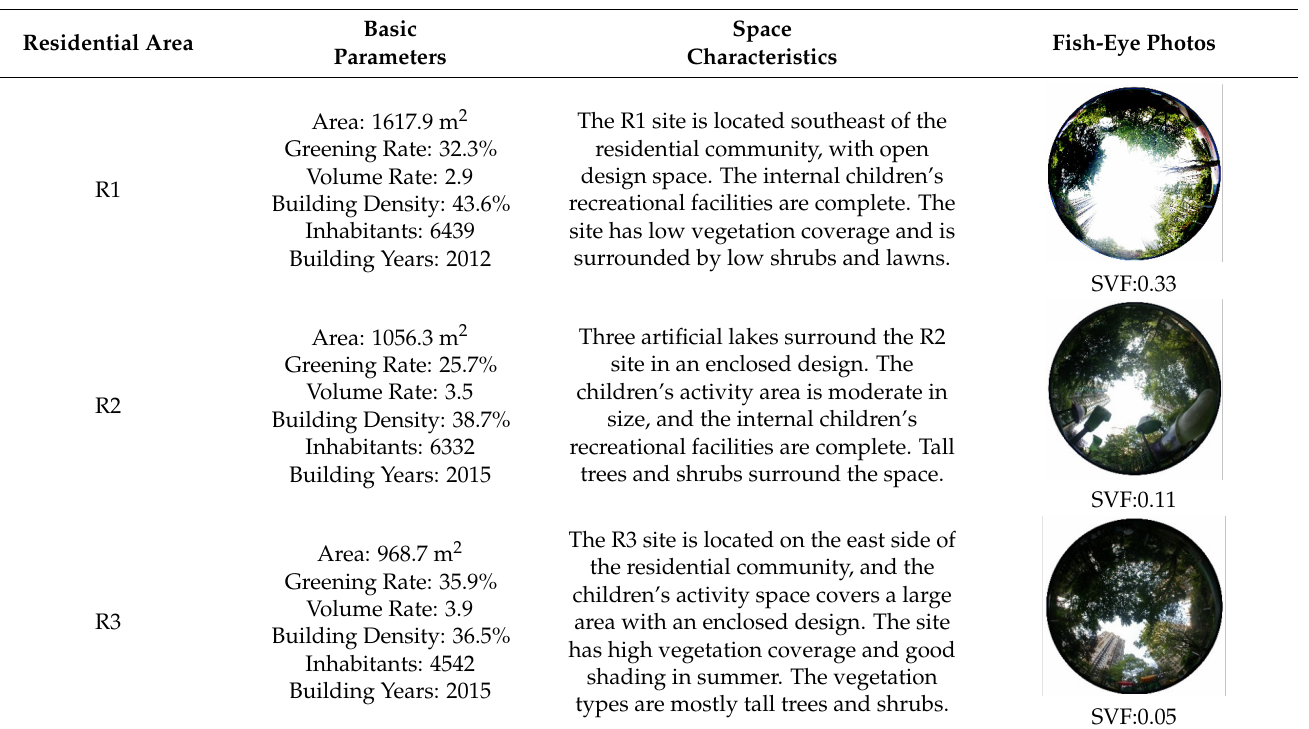
Figure 2. Monthly maximum/minimum/mean air temperature and mean relative humidity in Chongqing in 2001–2021. Table 1. Descriptions of the three residential children’s activity